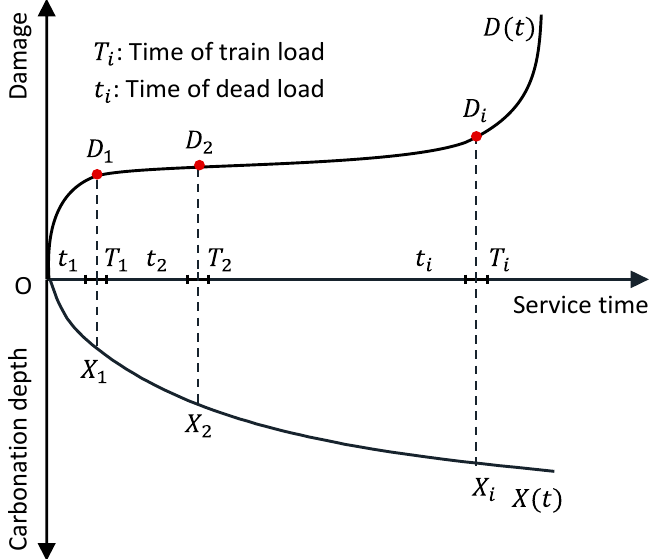
Figure 1. The coupled effects of train loads and carbonation environment during its service period.